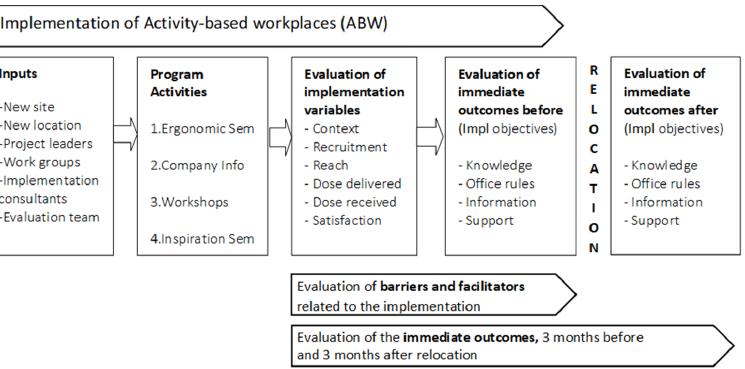
Figure 1. The logic model shows the process of implementation, resources (inputs), program activities and the evaluation of implementation variables and immediate outcomes in the present study. There is a diversity of frameworks for process evaluations [33] that evaluate whether interventions were implemented as intended, which can be useful for advancing our un- derstanding of how and why an implementation works [34]. We used a framework devel- oped by Linnan and Steckler [34], which utilizes six key process evaluation variables: con- text, recruitment, reach, dose delivered, dose received, and satisfaction. The aim of this study was to evaluate implementations of ABW in two offices within the same organization, where the same implementation strategy was used for both offices. More specifically, we looked at whether the program activities were implemented as planned and if they led to the intended changes. Evaluating two offices made it possible to examine how potential differences between certain implementation variables (i.e., re- cruitment, reach, dose delivered, and dose received) or between the program activities may have impacted the intended changes. Further, to deepen our understanding of what might influence the implementation process variable of relocation, we aimed to determine what individual- and organizational-level factors acted as barriers and facilitators to this process. The following research questions were addressed: (1) Was the relocation to ABWs, in two geographically separated offices within the same organization, implemented as intended with regard to the six process variables of context, recruitment, reach, dose delivered, dose received, and satisfaction [34]? (2) To what extent did the implementation process accomplish the intended changes with regard to increased knowledge about ABW, understanding office rules, and sat- isfaction with information and support? (3) What key factors, barriers, and facilitators, related to the implementation process, were perceived by the employees? 2. Materials and Methods 2.1. Background This study observed how a large government agency (the Swedish Transport Admin- istration) conducted the implementation of activity-based workplaces (ABW) at two office sites, office A (OA) and office B (OB), located in two cities in Sweden. This organization is a national agency with central and local administrations. Most employees have flexible working arrangements (such as flex-time or unregulated working hours), work remotely and in projects with shorter office meetings, or work via web-based meetings and occa- sional visits to different office sites [35]. According to the organization’s management, working in these ways requires new approaches to utilizing office space in order to meet employees’ needs and increase flexibility around office occupancy.